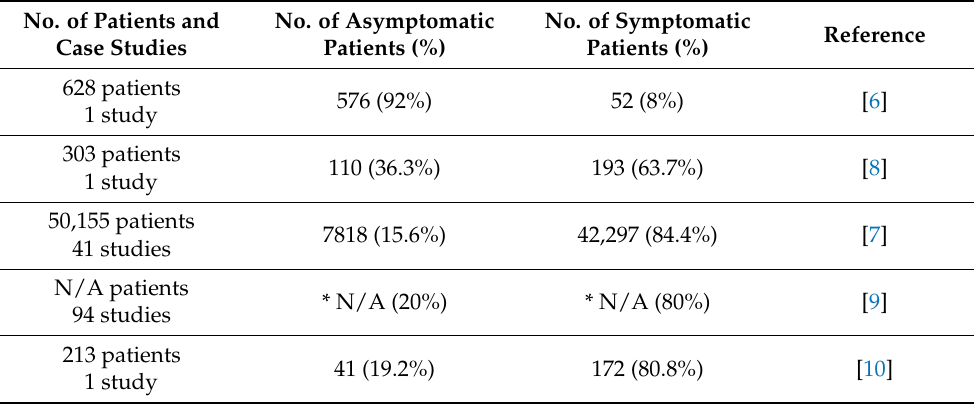
Table 1. Collation of numerous studies showcasing the number and percentage of patients presenting asymptomatic and symptomatic for diagnosis with SARS-CoV-2 infection. No. of Patients